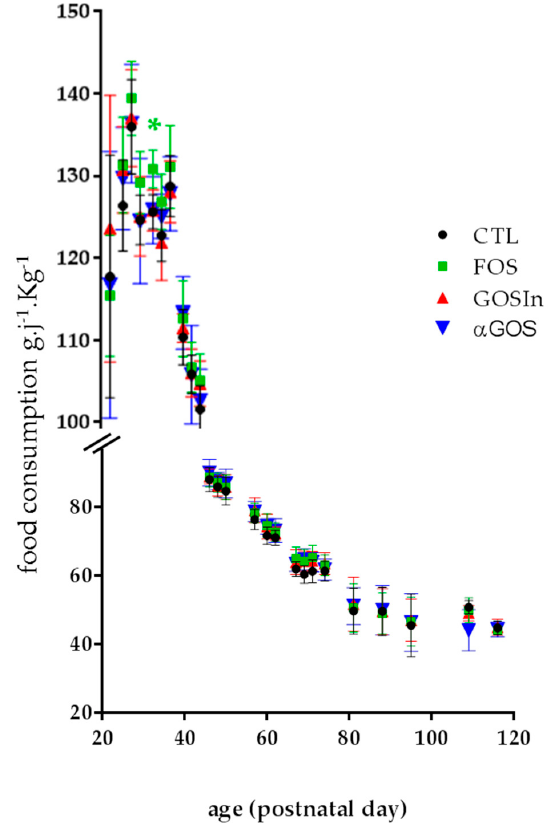
Figure 8. Daily consumption of food in the post-weaning stage, expressed as kilograms of bodyweight. The asterisk indicates a significant difference between FOS and CTL groups ( p < 0.05). Data are means ± SD ( n = 7 to 8 by group and day).